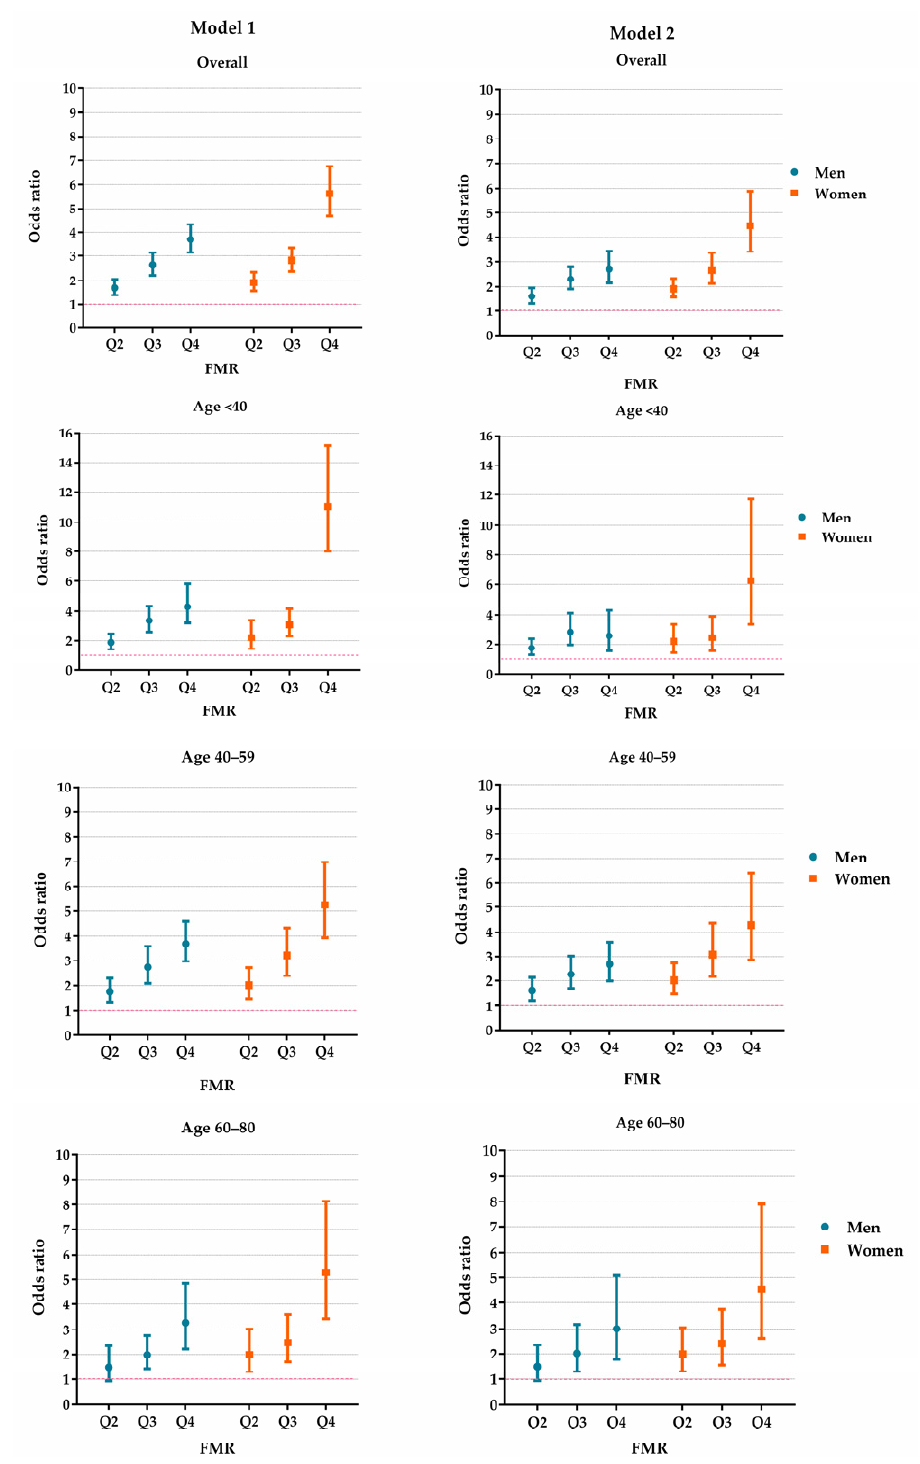
Figure 2. The effect of FMR on HUA in the study population. Model 1 was adjusted for age, rural/urban location, educational level, study sites, alcohol drinking status (male only), smoking status (male only), hypertension, diabetes, dyslipidemia and serum creatine. Model 2 was additionally adjusted for body mass index based on Model 1. FMR: fat-to-muscle ratio. HUA: hyperuricemia. Q2–Q4: the values fall in the 25–49th, 50–74th and 75–100th centiles of